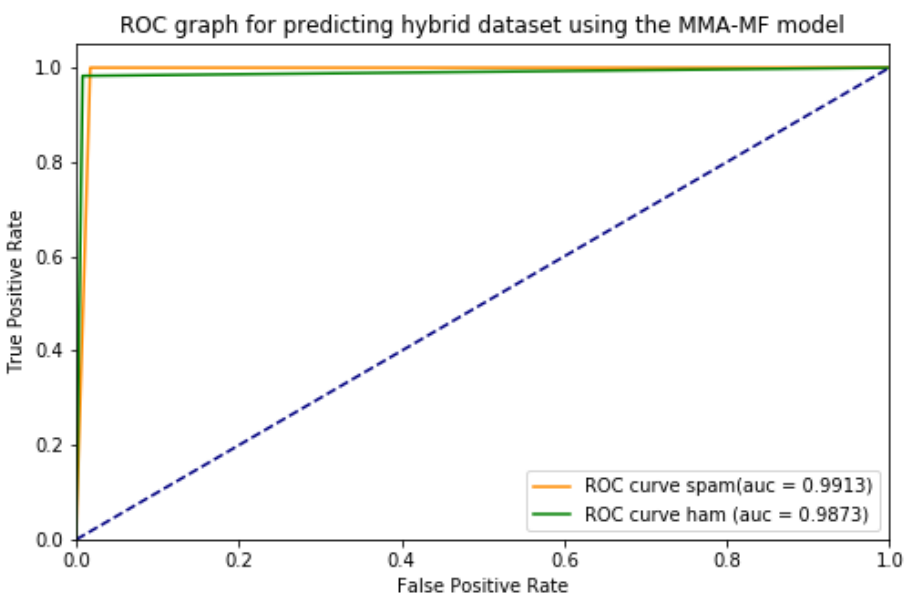
Figure 7. ROC chart for Hybrid Dataset